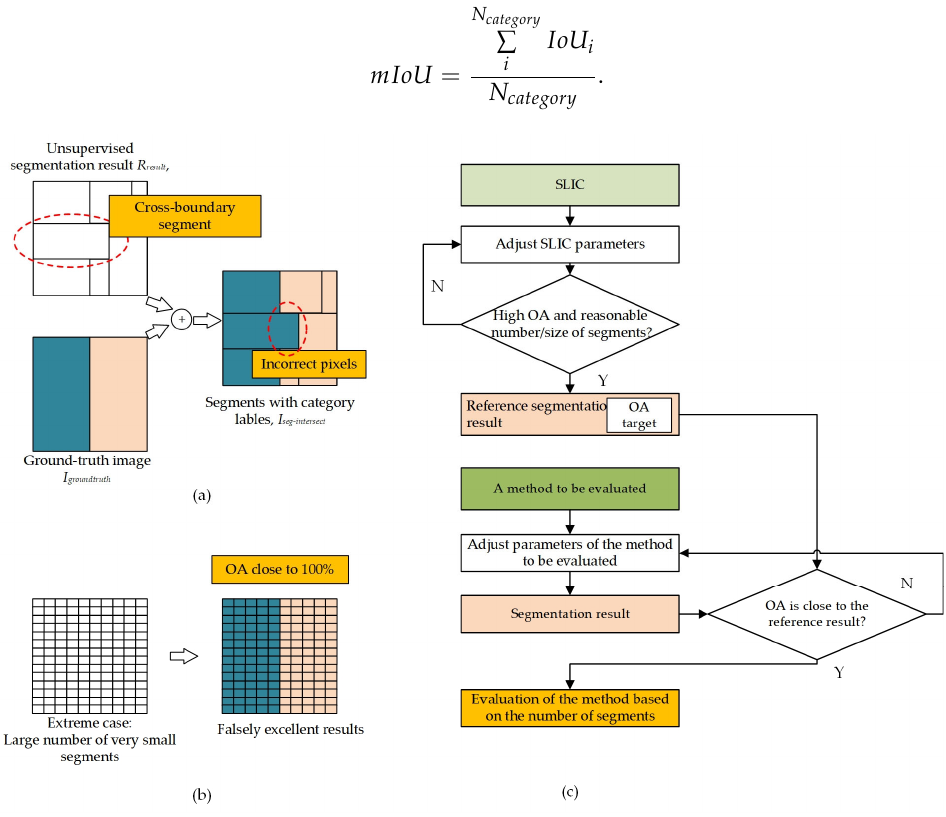
Figure 6. Evaluation strategy: ( a ) obtaining the OA of a set of segmentation results; ( b ) extreme results in which the OA is very high but comparative value is lost; and ( c ) evaluation method based on a reference OA.